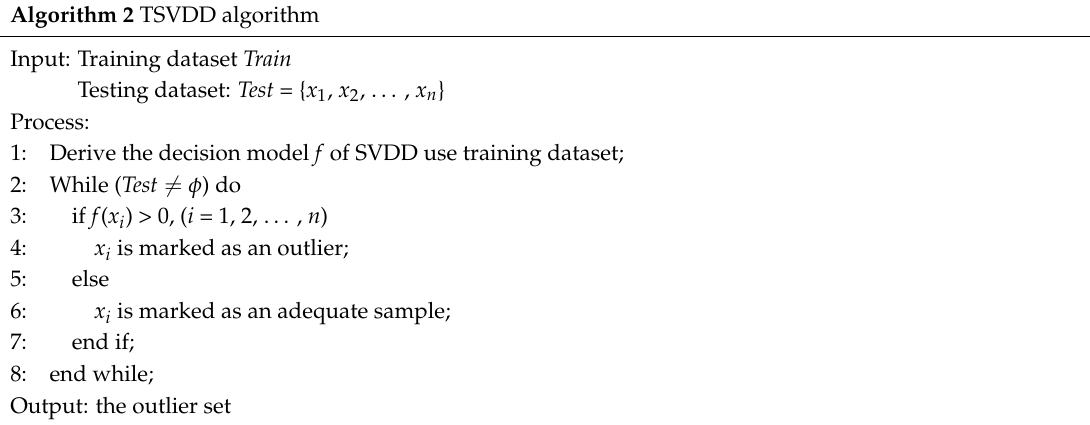
Algorithm 2 TSVDD